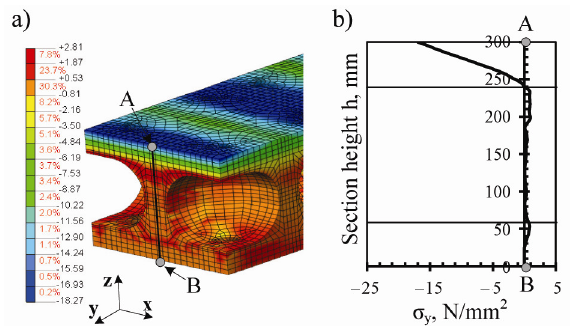
Fig. 13. Stress distribution in the concrete of the slab cross- section, point 2: a) overall image; b) graphic image